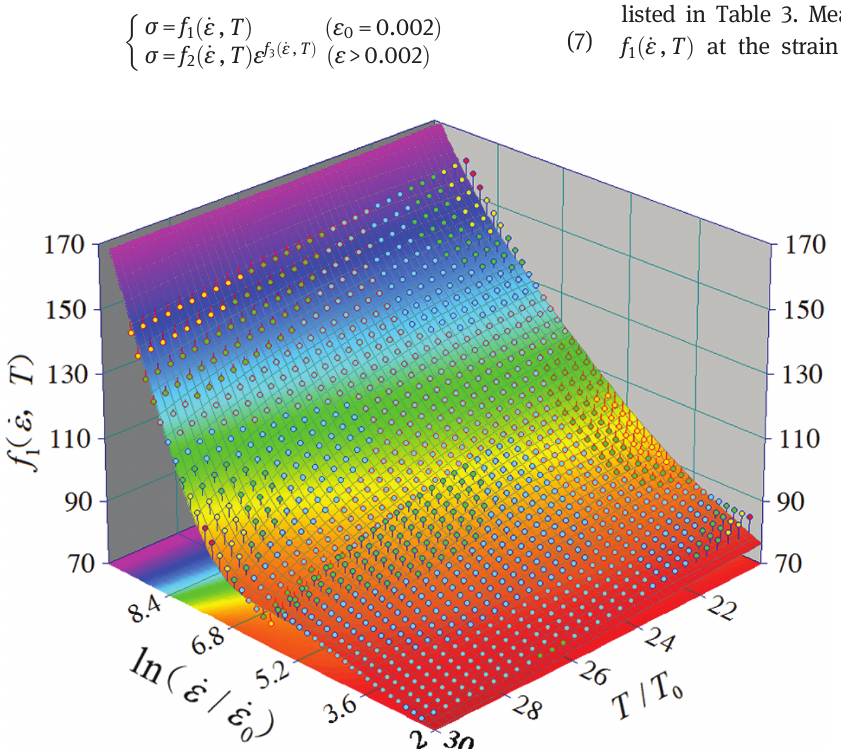
Figure 10: Fitting surface under middle temperature region at ε = 0.002.